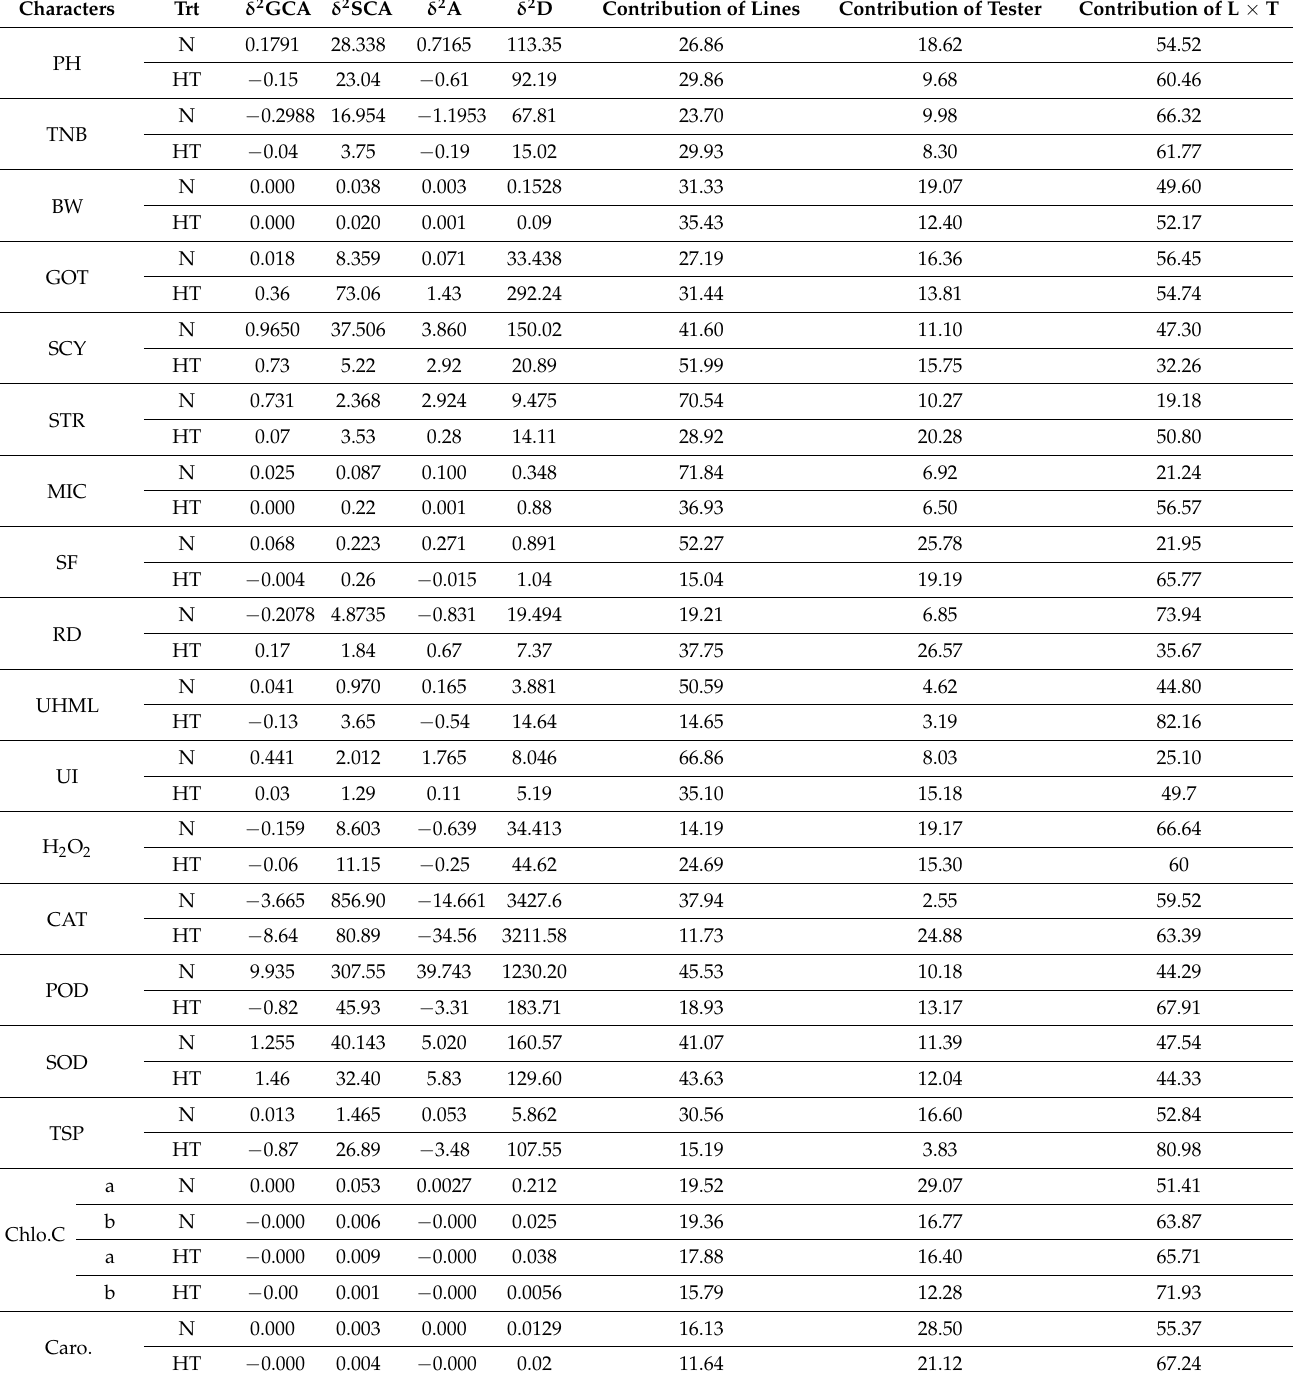
Table 8. First year genetic components and proportional contribution of lines, testers and their interactions to total variance under normal and high temperature stress